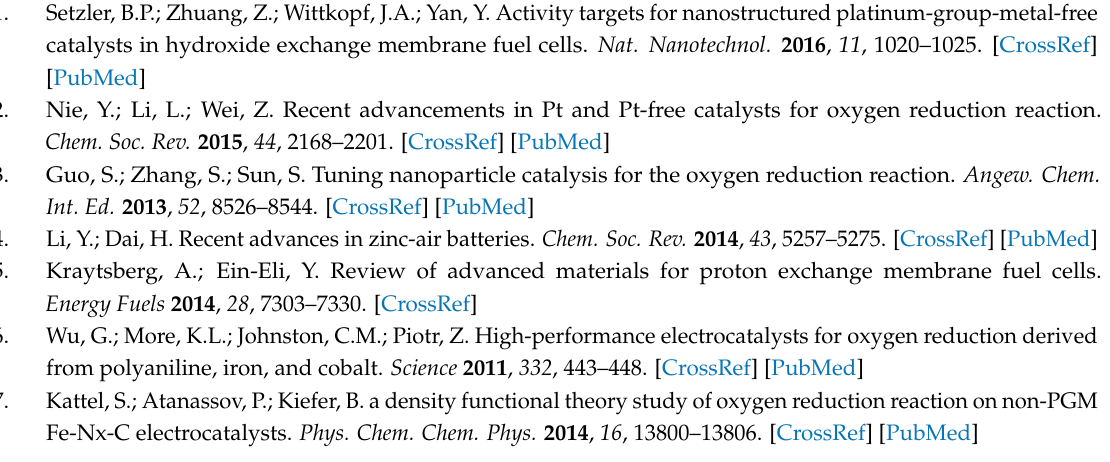
Figure S1: (a), (b) and (c) TEM images of the CF nanoparticles at higher magnification (20 and 10 nm scale bar). (d), (e) and (f) TEM image of the Vulcan carbon. (g), (h) and (i) TEM image of the CF-VC catalyst., Figure S2: Comparison of single cell performance and kinetic region (inset) between this work and state of the art non-PGM cathode fuel cell work. a), b) i-V curves and i-power density curves between this work and non-PM cathode FU [10], Fe/N/C nanotubes [8], N-C-CoO x [9] and CNT/PC [29] in AEMFC, Table S1: Binding energy of the cobalt and iron atoms in the XPS spectra of various